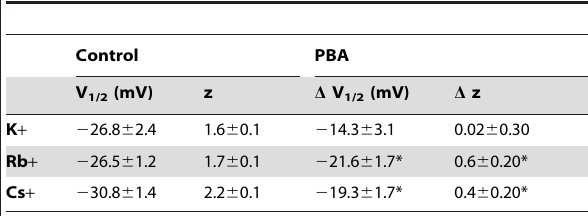
Table 3. Electrophysiological Properties of Q1 with different charge carriers.